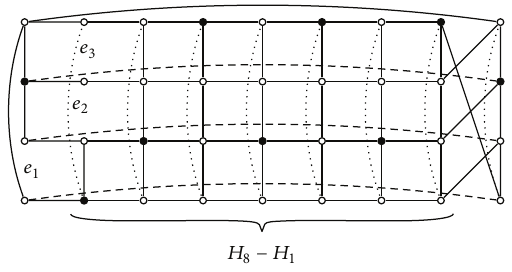
Figure 2: Dominating sets (bold vertices) of 𝐺 9 −{𝑒 1 , 𝑒 2 ,𝑒 3 } in Case 2 of Lemma